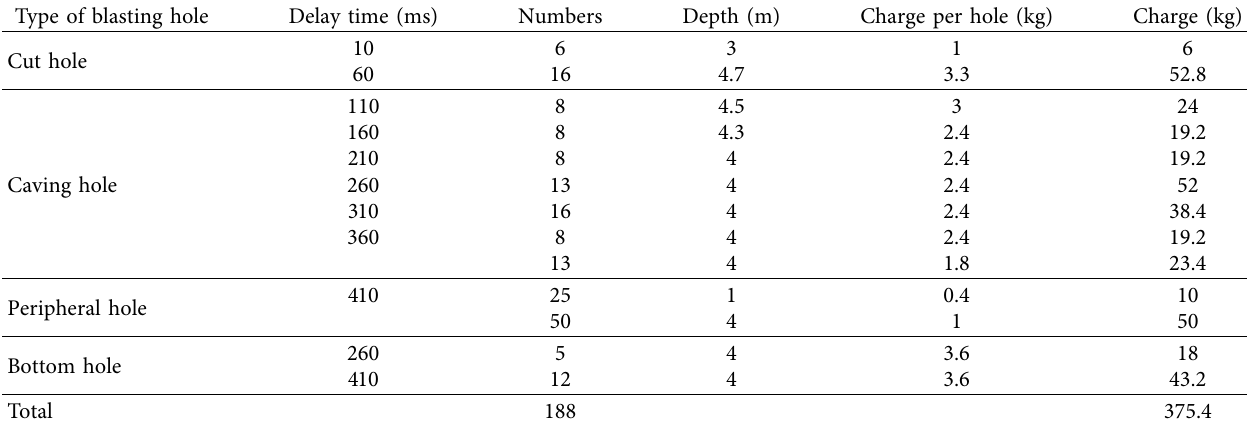
Table 1: Blasting parameters of upper bench of tunnel.